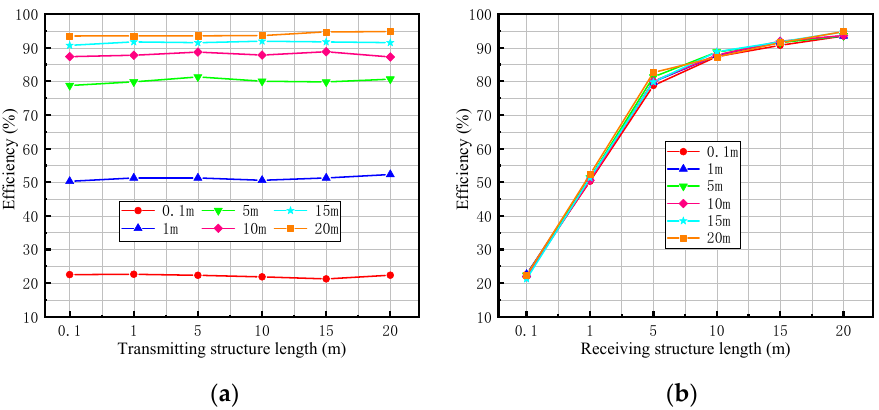
Figure 7. Influences of structure lengths on transmission efficiency under asymmetry: ( a ) length of transmitting structure; ( b ) length of receiving structure.